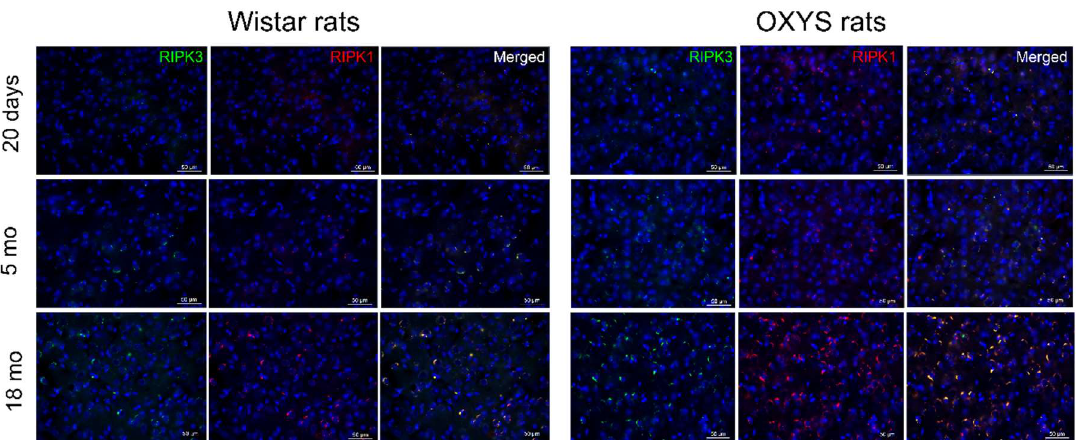
Figure 4. Markers of necroptosis. Representative images of cortex cryosections immunostained for receptor-interacting protein kinase 1 (RIPK1) (red) and RIPK3 (green) from 20-day-old and five- and 18-month-old OXYS and Wistar rats.